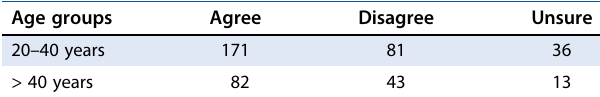
Table 6: Relationship between age and ‘ decision making and delegation of duty ’ Age groups